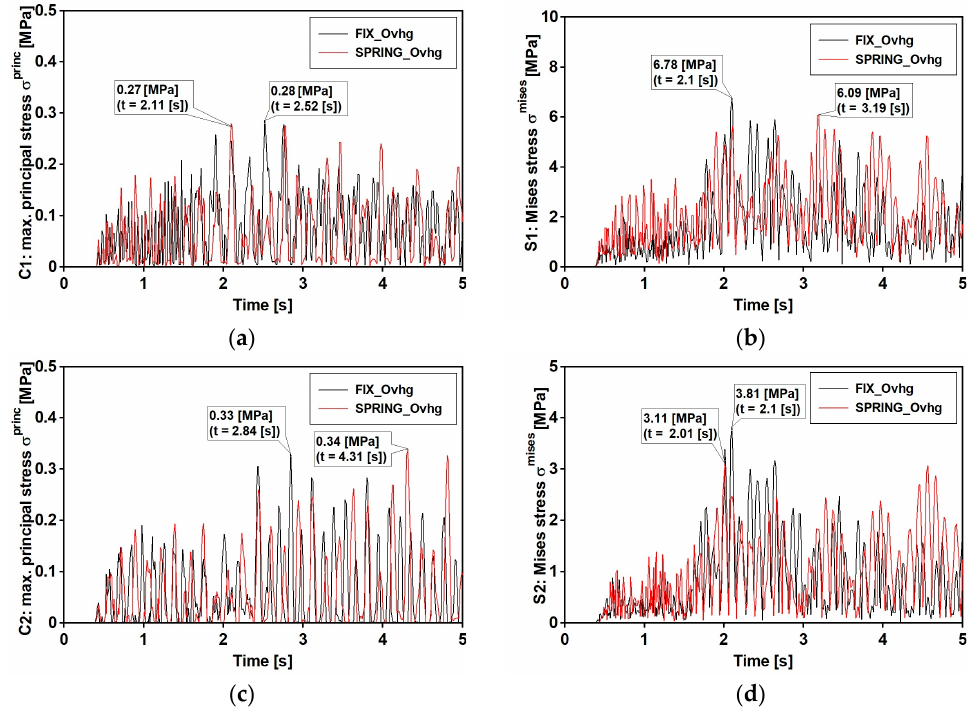
Figure 21. Mining-induced stress [MPa] time histories: event with narrow band spectrum. FIX_Ovhg model (black line) and SPRING_Ovhg model (red line): ( a ) positive value of principal stresses σ princ at points C1 ( b ) positive value of principal stresses σ princ at points C2; ( c ) the von Mises stresses σ mises for points S1; ( d ) the von Mises stresses σ mises for points S2.